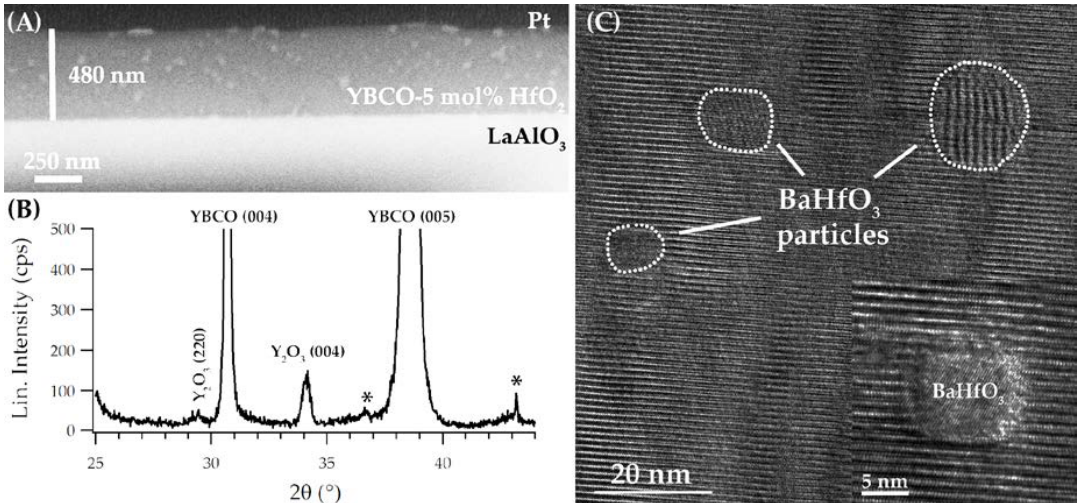
Figure 5. Composition and microstructure of an ink-jet-printed 5 mol% HfO 2 -YBCO nanocomposite film with three deposition runs after full thermal processing. ( A ) Cross-sectional SEM image and ( B ) XRD θ − 2 θ pattern. ( C ) High-resolution TEM image showing isolated, randomly oriented BaHfO 3 particles in the YBCO matrix. Inset: close-up of a BaHfO 3